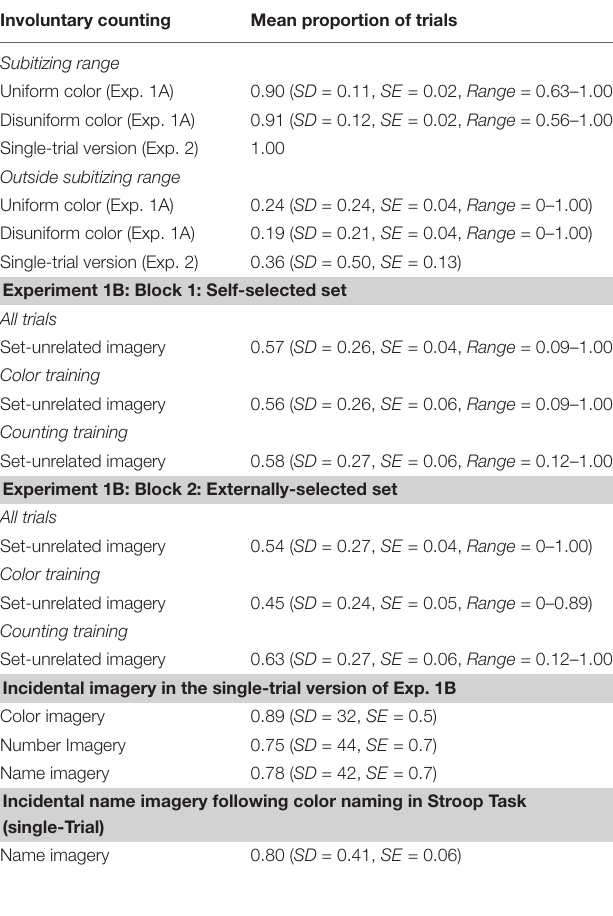
TABLE 2 | Imagery as a function of set, training, and mental operation: Counting, object naming, or color naming. Involuntary